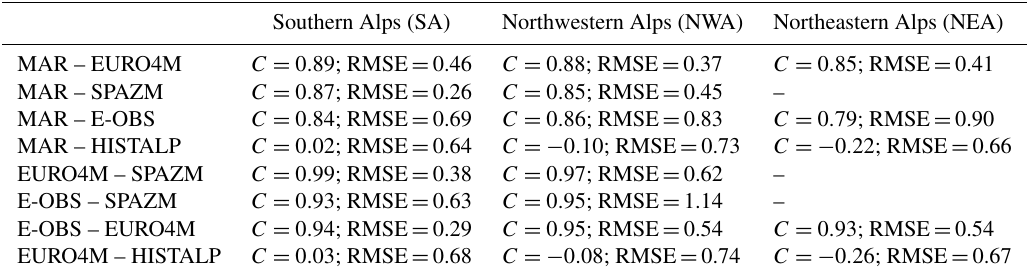
Figure 3. Annual mean precipitation (mmd − 1 ) averaged over the southern Alps (SA), the northwestern Alps (NWA) and the northeastern Alps (NEA) over the period 1971–2008 (top row) and corresponding monthly averaged seasonal cycle over the same period (bottom row). The area covered by the SA, NWA and NEA domains can be visualized in Fig. 1. MAR outputs are shown with the observational datasets EURO4M, SPAZM, HISTALP and E-OBS (see text for details). E-OBS (orange solid line) is provided with an estimation of the observational uncertainty (orange dashed lines). Table 2. Correlation Pearson coefficient computed over 1971–2008 ( C ) and root-mean-square error (RMSE) between the time series of precipitation data over 1971–2008 for the three different sub-areas described in Fig. 1. All the correlations are significant ( p value > 0.05), except those computed with the HISTALP